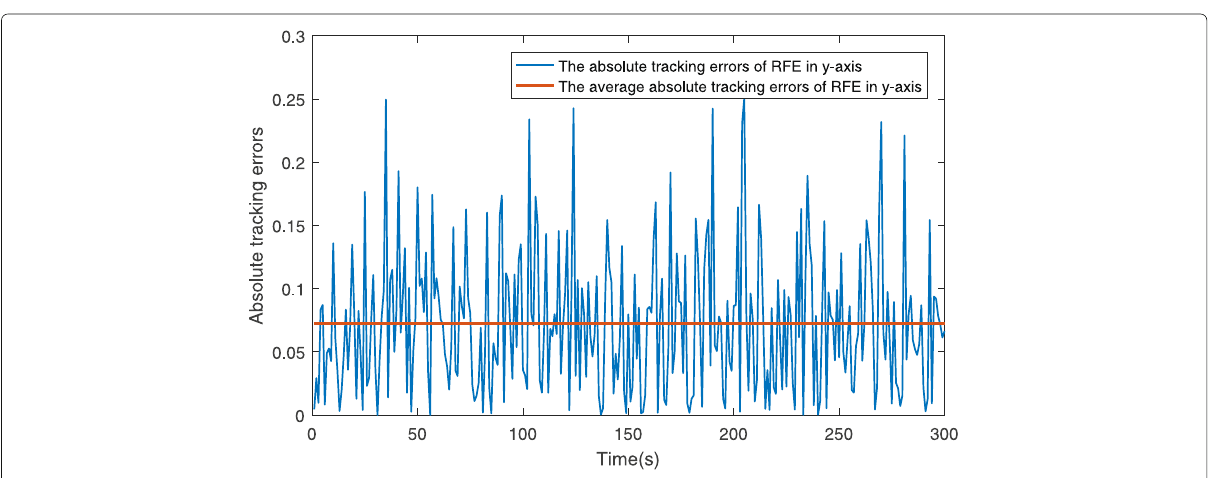
Fig. 4 The absolute tracking errors of RFE in y -axis with a i =